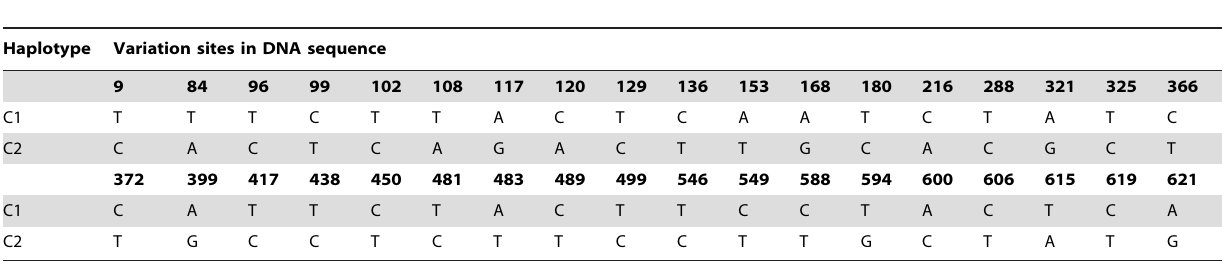
Table 3. Variation sites in DNA sequences for mitochondrial COI of Bactrocera species from various localities.